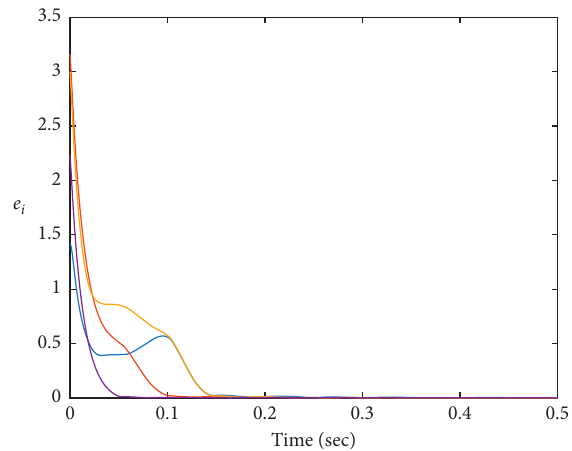
Figure 3: The tracking errors e